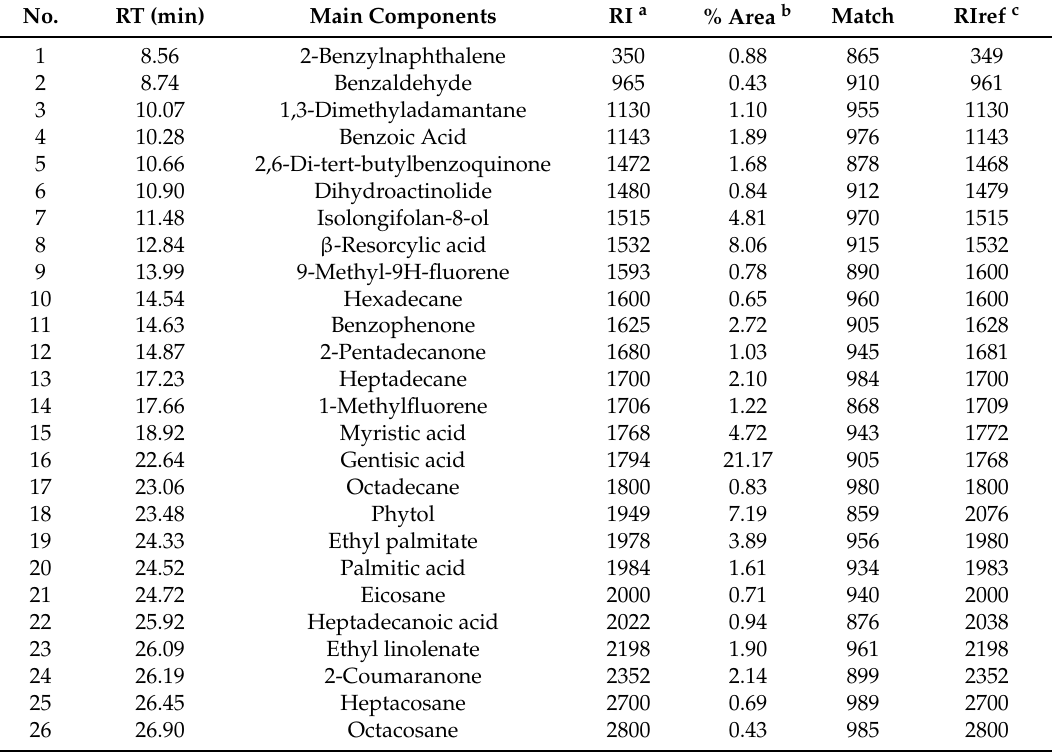
Table 1. Main components of AcOEt